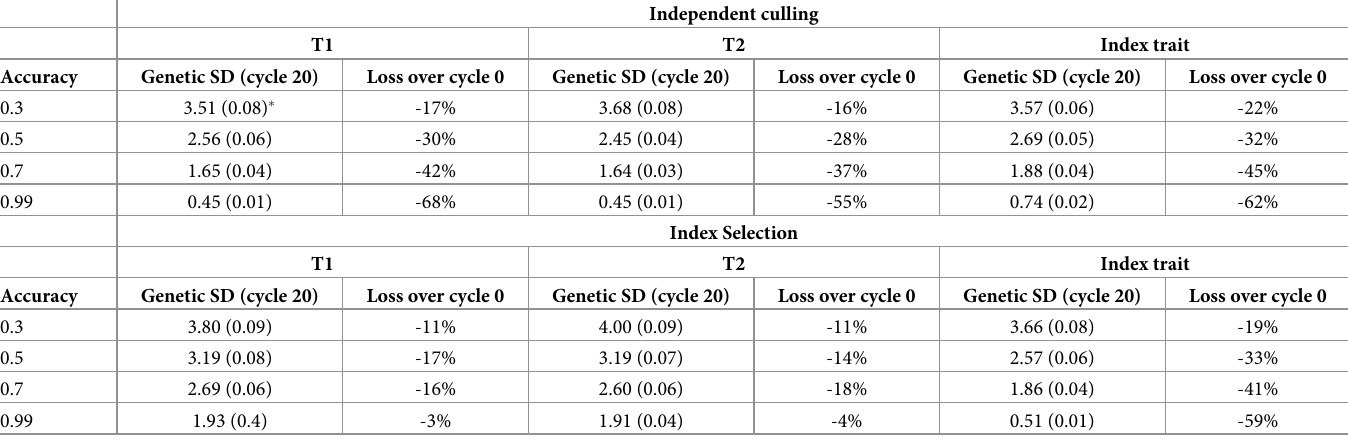
Table 2. Mean genetic standard deviation (Genetic SD) of parents in cycle 20 and loss in genetic standard deviation in cycle 20 in comparison to the genetic stan- dard deviation in cycle 0 (Loss over cycle 0) for trait 1 (T1), trait 2 (T2) and the index trait using either optimal independent culling or index selection with different levels of accuracy, unfavourably correlated traits, and T2 relative economic importance of 1.0.